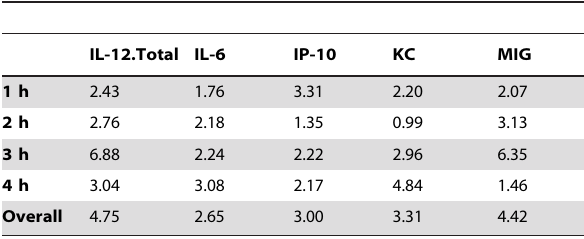
Table 1. Top five significantly different cytokine in ST vs. ST +